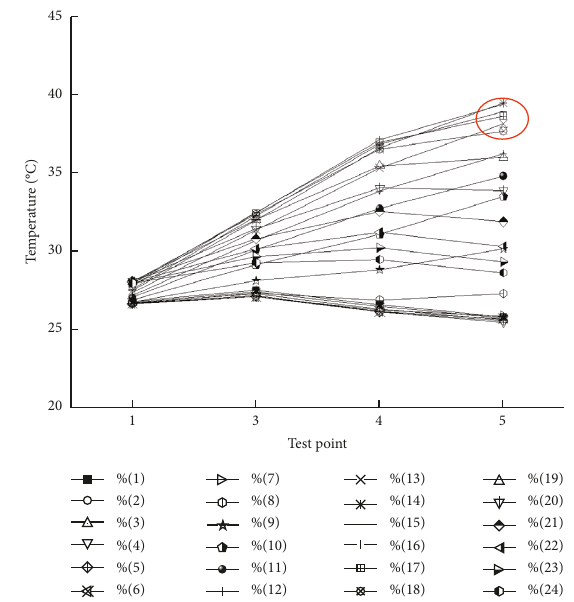
Figure 7: Temperature curve on the hour of the indoor side of the north-facing wall on July 11 (the hottest day during the test period).